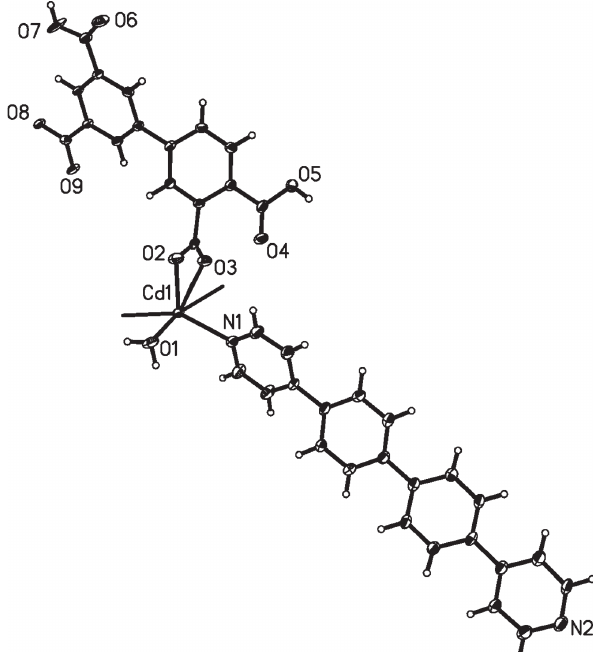
Table 1 contains crystallographic data and Table 2 contains the list of the atoms including atomic coordinates and dis- placement parameters.